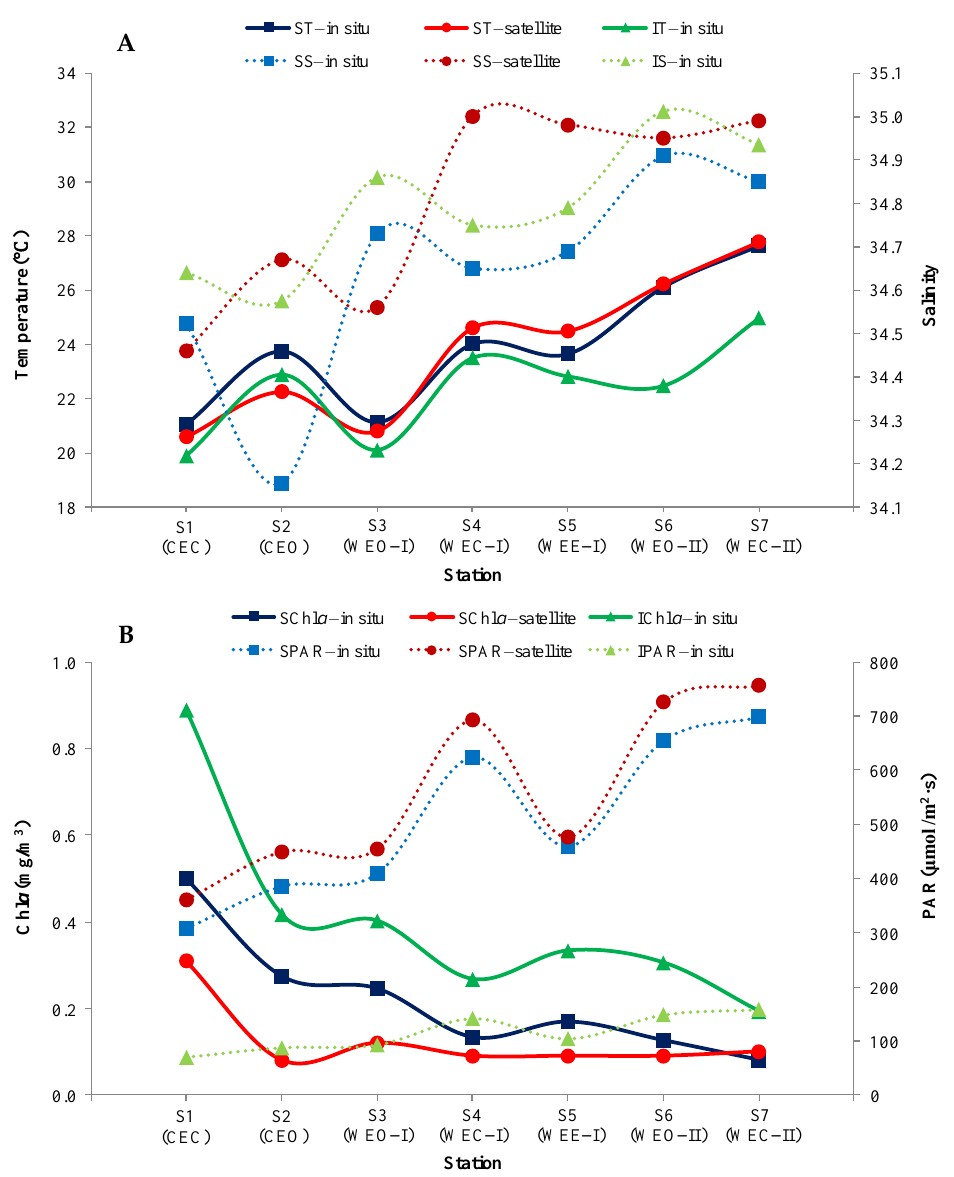
Figure 7. Trends in biogeochemical variables (( A ). temperature and salinity; ( B ). Chl a and PAR) acquired via satellite and in situ (ST: surface temperature; SS: surface salinity; IT: integrated temperature; IS: integrated salinity; SChl a : surface chlorophyll a ; IChl a : integrated chlorophyll a ; SPAR: surface photosynthetically active radiation; IPAR: integrated photosynthetically active